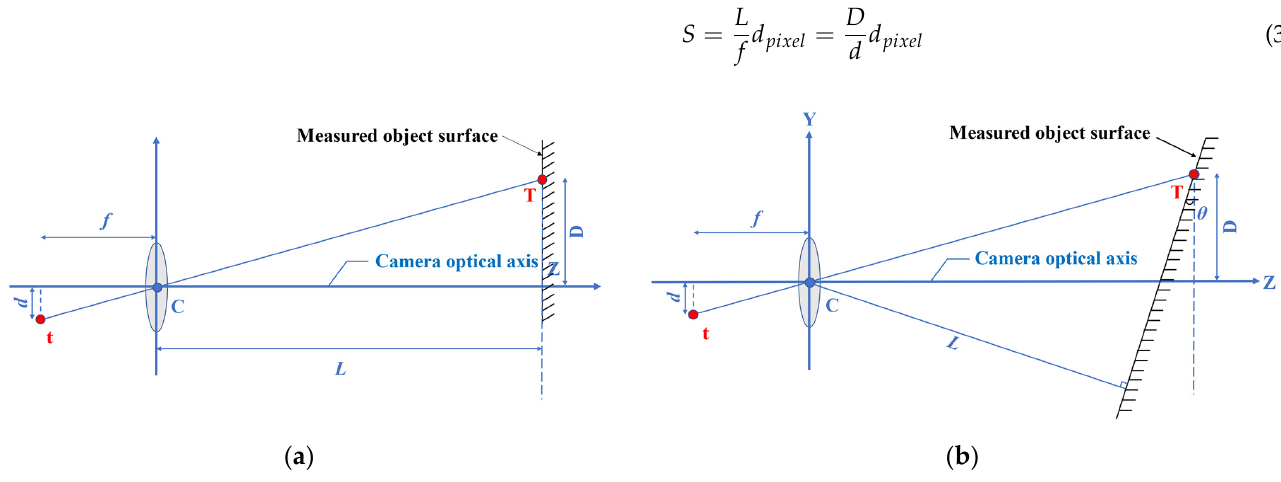
Figure 3. Scaling factor calibration method. ( a ) Camera optical axis orthogonal to measured object surface; ( b ) Camera optical axis intersecting obliquely with measured object surface.